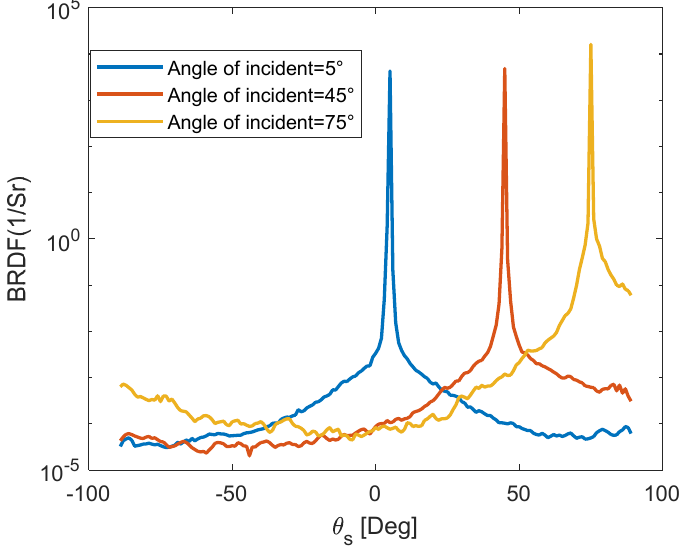
Figure 5. The BRDF measurement results under different angles of incidence. The scattered measurement can be converted into the PSD data with Equation (7).